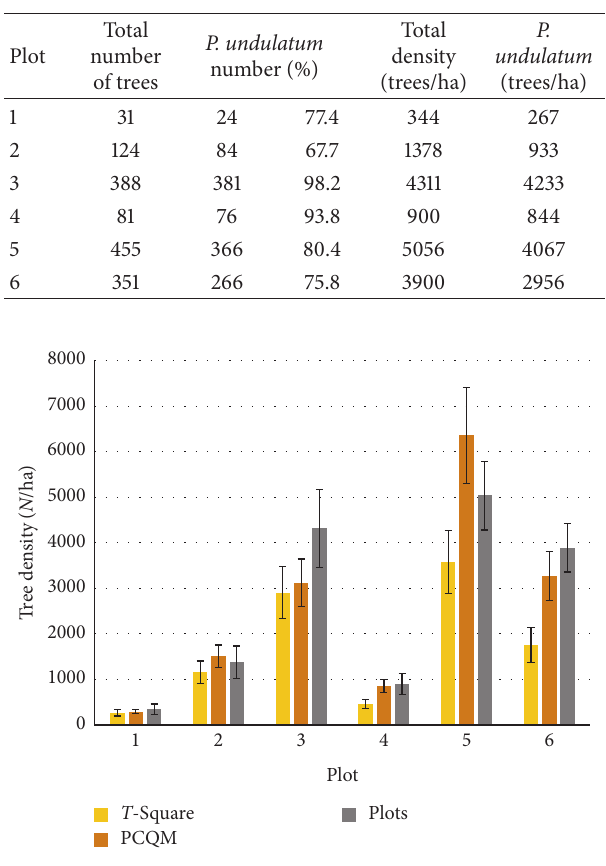
Figure 3: Tree density estimates and 95% confidence intervals obtained using the data collected at each plot, for 𝑇 -Square sampling ( 𝜆 2 ), Point Centered Quarter Method ( 𝜆 5 ), and quadrat